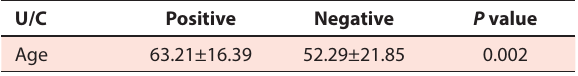
Table 1. Mean and standard deviation of age in patients with positive and negative urine culture (U/C)